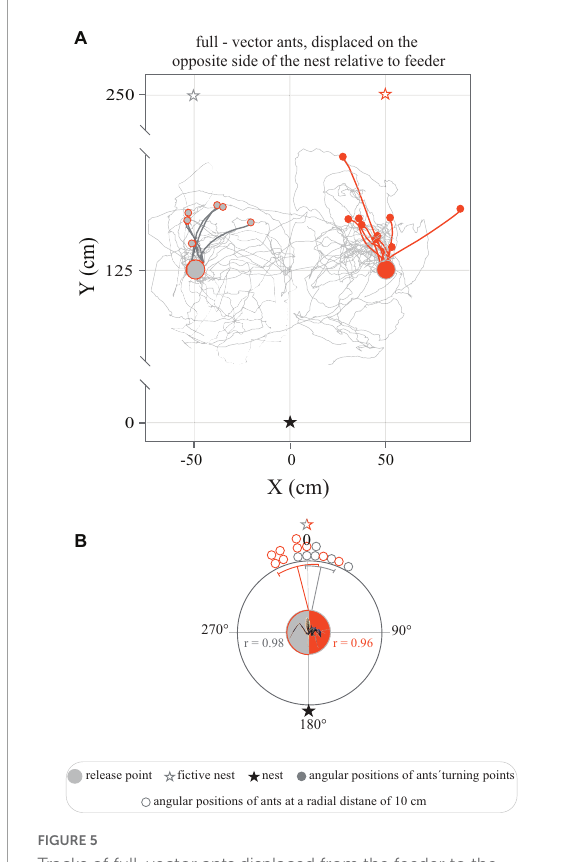
FIGURE5 Tracks of full-vector ants displaced from the feeder to the opposite side of the nest. (A) Trajectories represent the paths traveled upon the release of ants captured at the feeder and moved to the opposite side of the nest, with a 50 cm displacement right or left relative to the feeder. (B) Circular graphs represent the angular positions of ants at a radial distance of 10 cm from the release point in relation to the normalized fictive nest direction (0 ◦ ). Gray and orange lines indicate mean angles, associated sectors represent the 95% confidence interval of the mean. r represents mean vector